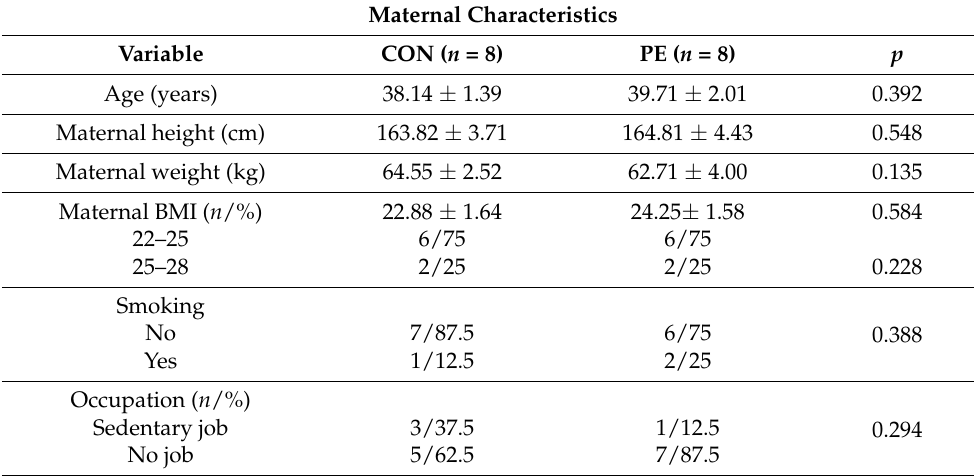
Table 2. Maternal characteristics at baseline.